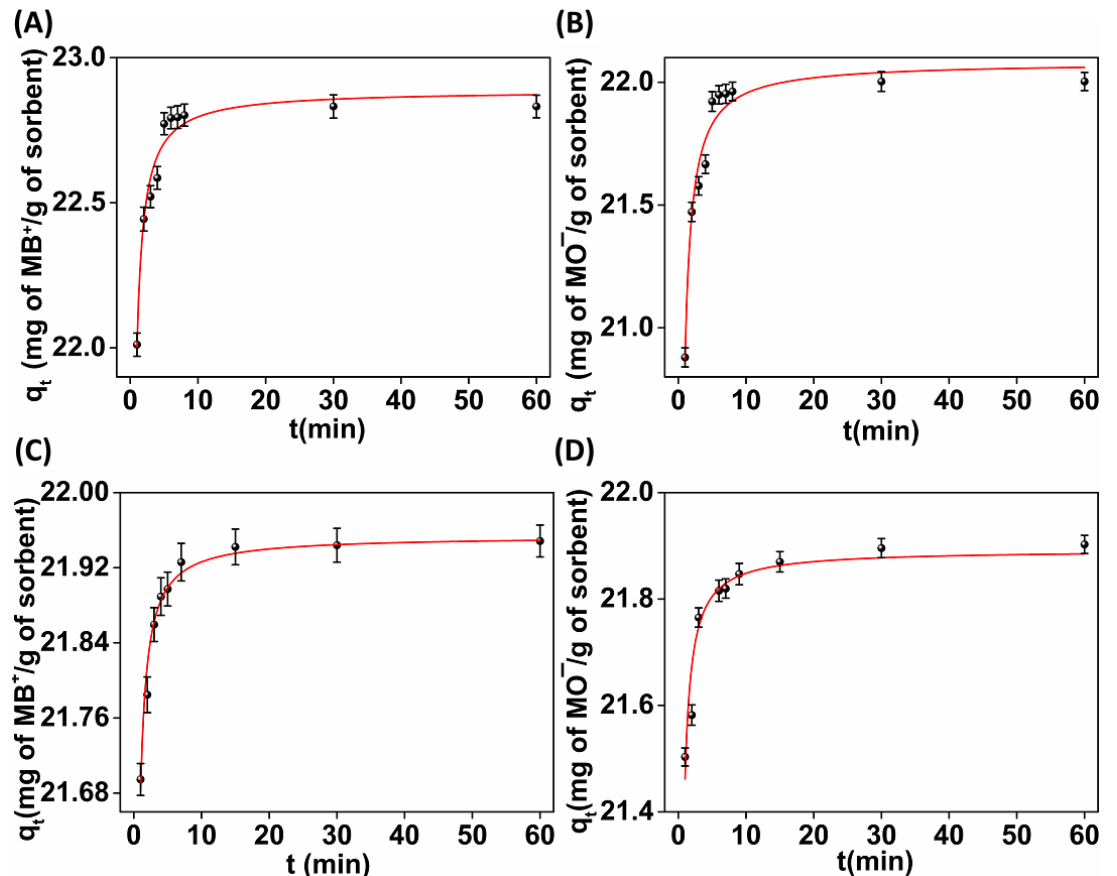
Figure 6. Fitting (red line) of the kinetics data with the Ho–Mckay’s pseudo-second-order equation for the sorption of ( A ) MB + and ( B ) MO − by (MOR-1/Bentonite)-HA ; ( C ) MB + and ( D ) MO − by (MOR-1/Clinoptilolite)-HA .